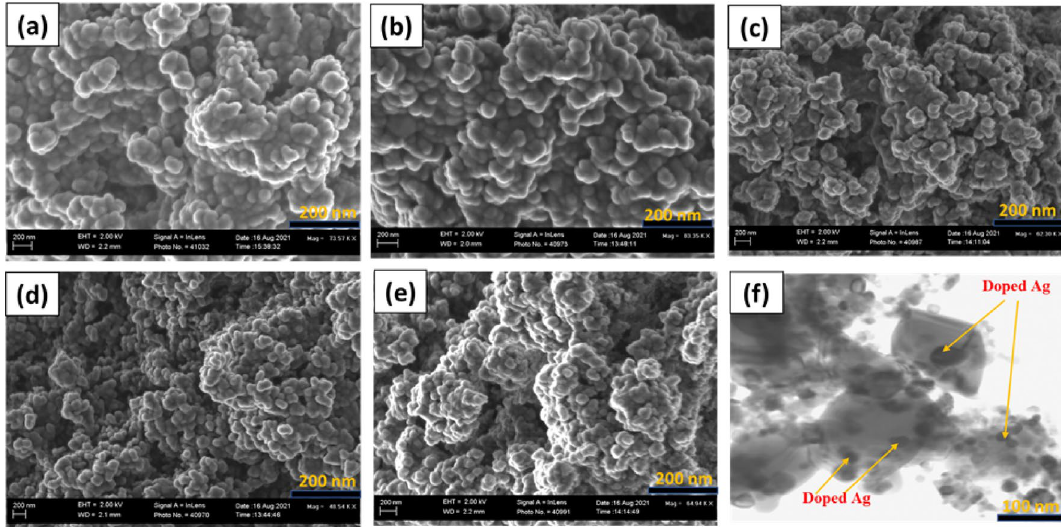
Figure 4. SEM images of pure ZnO ( a ) Ag–ZnO nanocomposites with ( b ) 1%, ( c ) 3%, ( d ) 5% ( e ) 8% Ag and TEM image ( f ) 8%